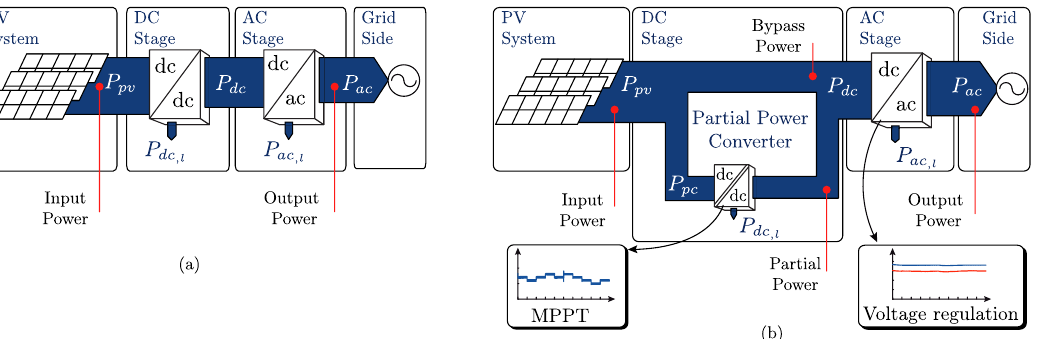
Figure 1. Diagram of the power flow in a PV system: ( a ) With a full power converter (FPC). ( b ) With a partial power converter (PPC).